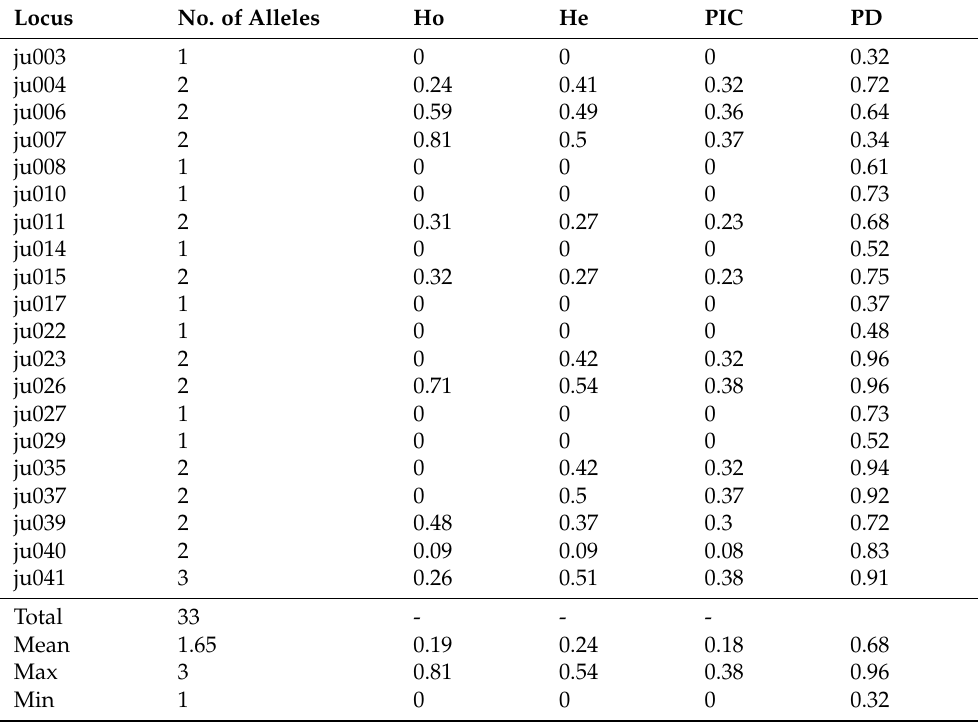
Table 3. SSR locus name, number of alleles, (Ho), (He) observed and expected heterozygosities, polymorphic information content (PIC), and discrimination power (PD) values for 22 developed polymorphic microsatellite loci in a sample of 29 tomato landraces.